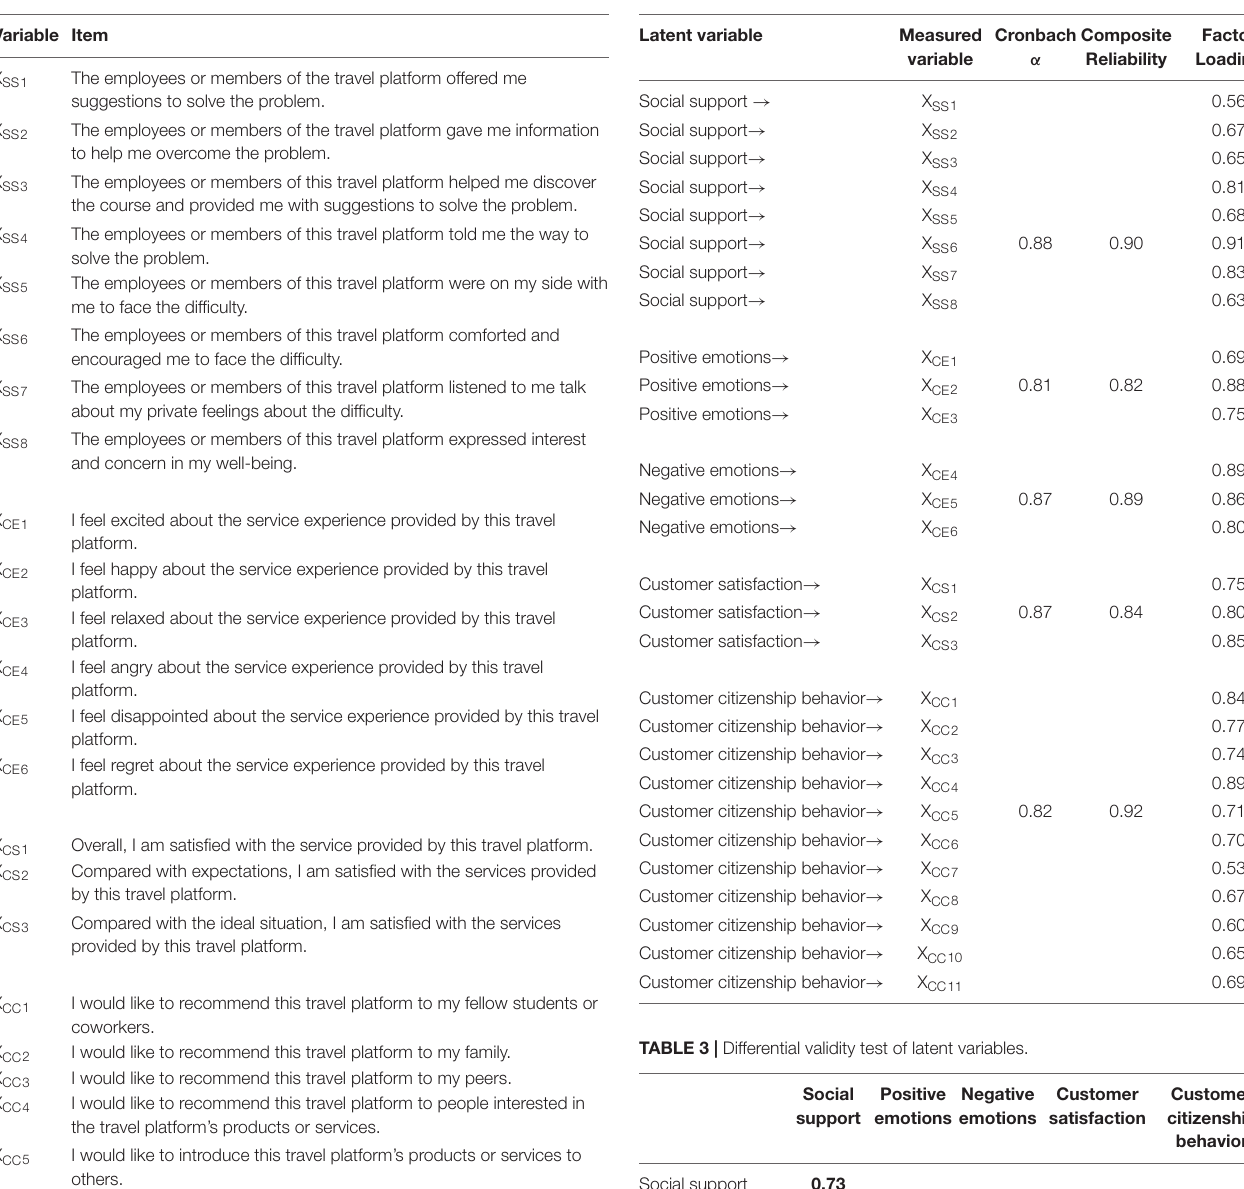
TABLE 2 | Test indicators and fitting results of the measurement model.